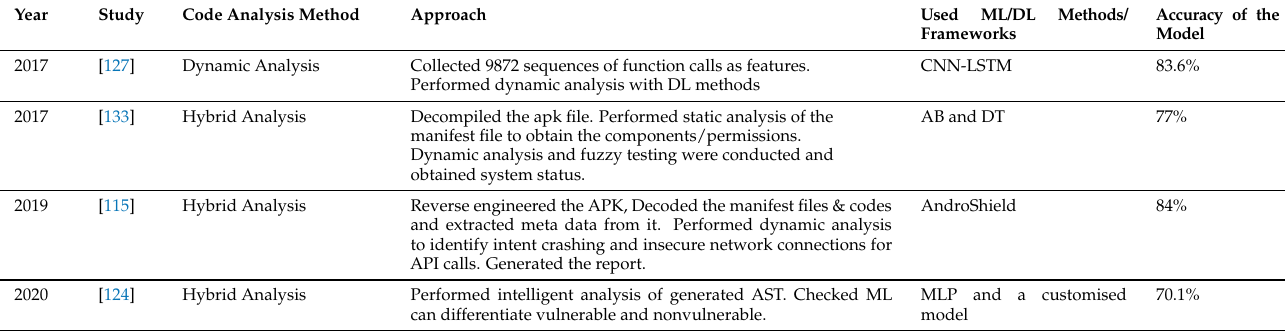
Table 10. Android vulnerability detection mechanisms (Model accuracy is below 90%).